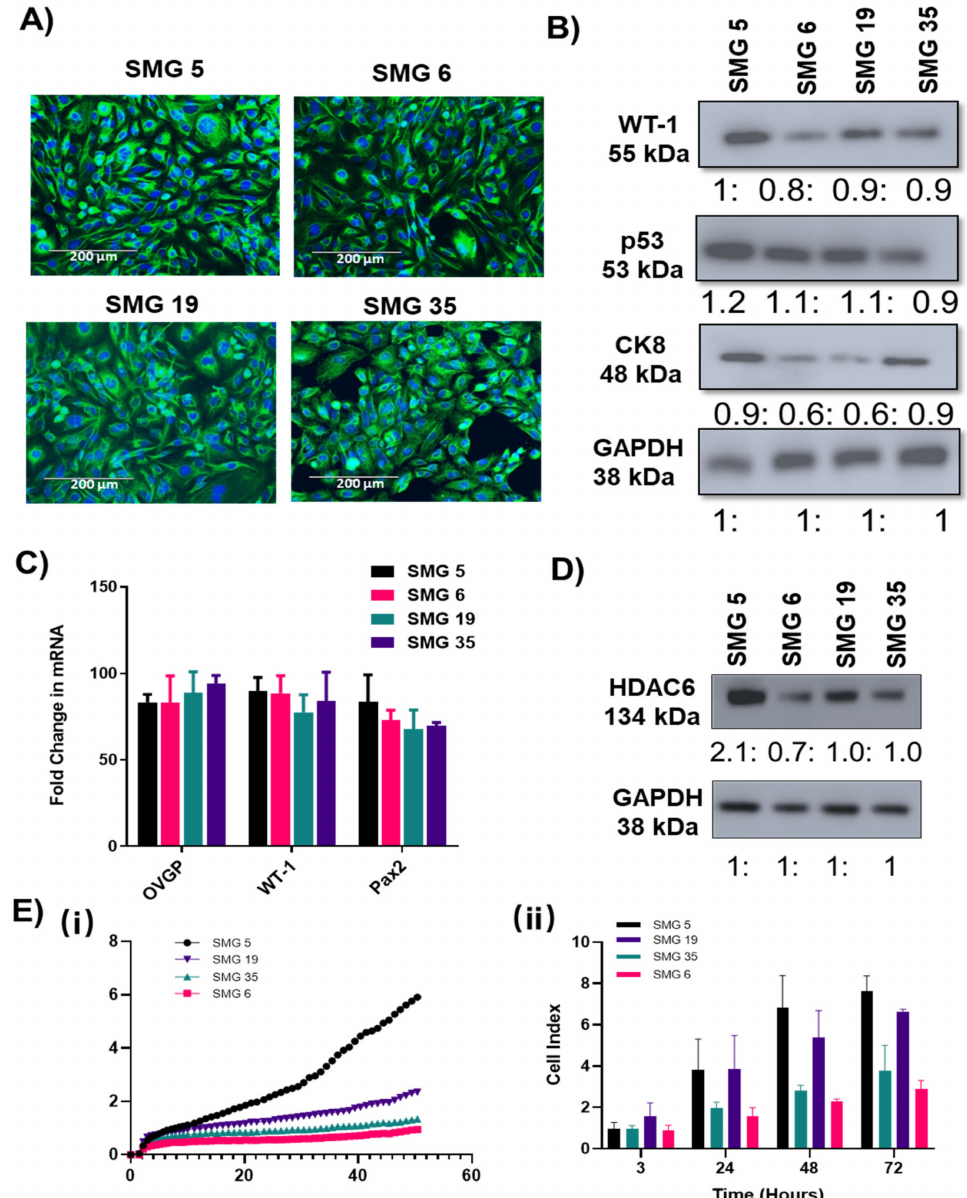
Figure 2. Molecular profiling of new established SMG cells: ( A ) Immunocytochemical analysis for the expression of ovarian epithelial biomarker protein CK8 in SMG ovarian cancer cell lines. (Scale bar = 200 µ m) ( n = 3). ( B ) Western blotting showing expression profiles of ovarian markers including wild type (WT)-1, p53, and CK8. ( n = 3 ± SEM). Uncropped Western Blots are available in Figure S6. ( C ) qRT-PCR showing gene expression profiles of ovarian markers including WT-1, OVGP, and Pax8 in SMG ovarian cancer cell lines. Delta CT values were normalized to the housekeeping gene β -actin. n = 3 ± SEM. ( D ) Representative images of basal levels of HDAC6 in SMG cells measured by western blot analysis. GAPDH was used as a loading control for both blots. n = 3 ± SEM. Uncropped Western Blots are available in Figure S7. ( E ) / ( i ) Representative graphs from the real time xCELLigence proliferation system.( E ), and average data at selected time points( ii ). Cell index values taken from the xCELLigence system monitoring the cells at time intervals, observing the rate of adhesion / spreading (3 h) and proliferation (6–70 h). Wells were analyzed in duplicate, and two biological replicates were performed to validate results, n = 2 ±